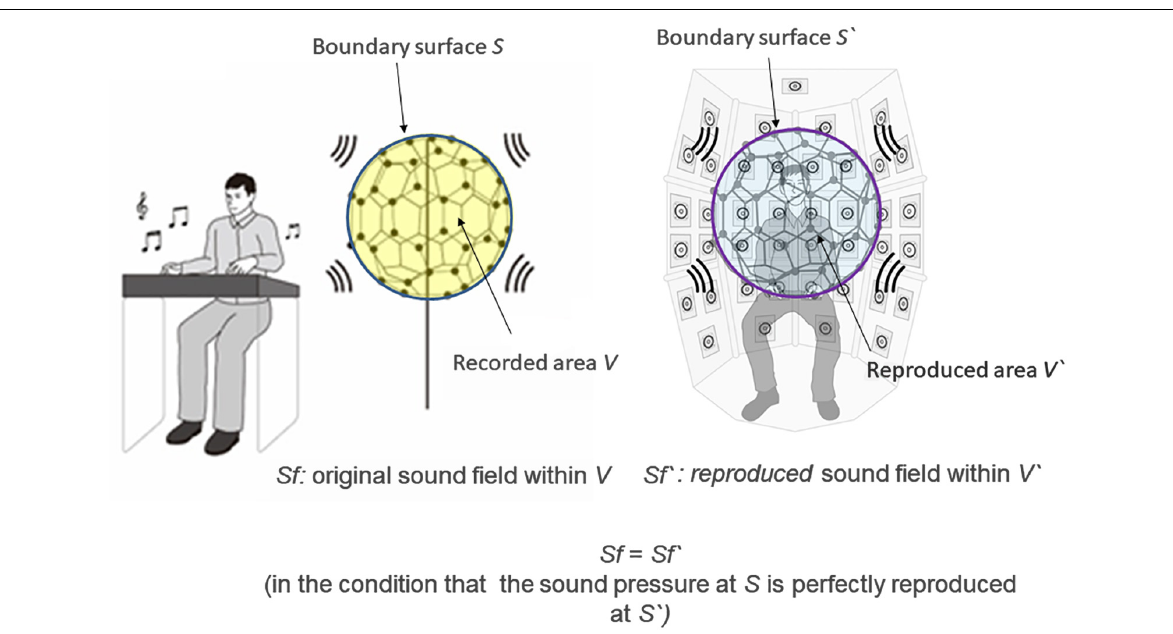
FIGURE 2 | Scheme of the boundary surface control (BoSC) principle. Left: Original sound was recorded with a microphone array. Sf stands for the original sound field within the enclosed space of the microphone array (defined as recorded area V ), and S stands for the boundary surface of the recorded area V . Right: Recorded original sound was reproduced in a reproduction room. We imagine that there was the same microphone array as in the left panel at the listening position, and let Sf (cid:48) stand for the reproduced sound field within the enclosed space of the virtual microphone array (defined as reproduced area V (cid:48) ) and let S (cid:48) stand for the boundary surface of the reproduced area V (cid:48) . If the original sound pressure at S is perfectly reproduced at S (cid:48) , Sf (cid:48) is mathematically completely the same as Sf